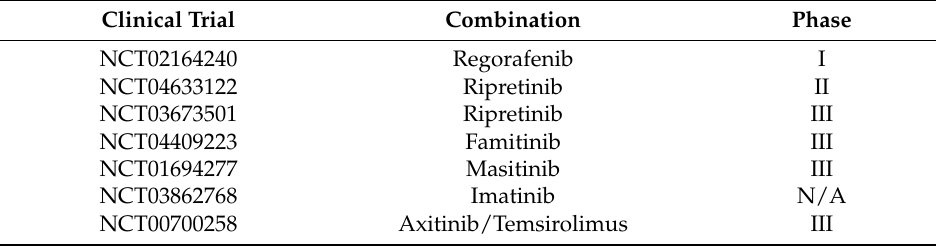
Table 4. Sunitinib ongoing clinical trials.